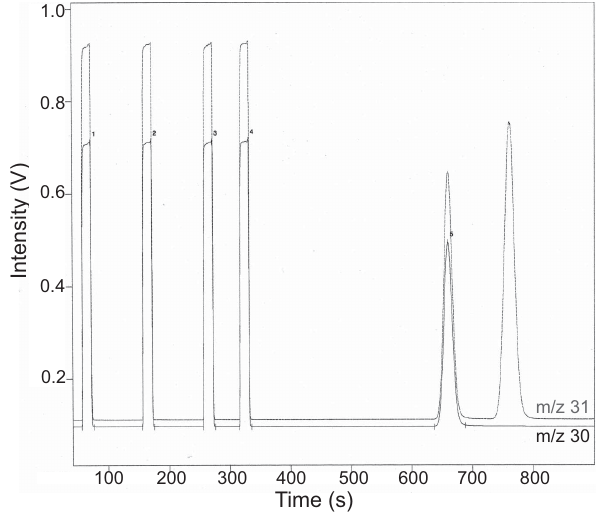
Figure 4. Typical chromatogram of background air sample obtained in a fragment-ion (NO + ) monitoring run. The x axis shows elapsed time after the start of heating of the cryofocusing trap. After the peaks of reference N 2 O injected from GC-IRMS interface (no. 1– no. 4), sample N 2 O peak appears (no. 5). The peak elution about 100s later is only detected on m/z 31 trace and is CF + derived from a fluorinated carbon species.